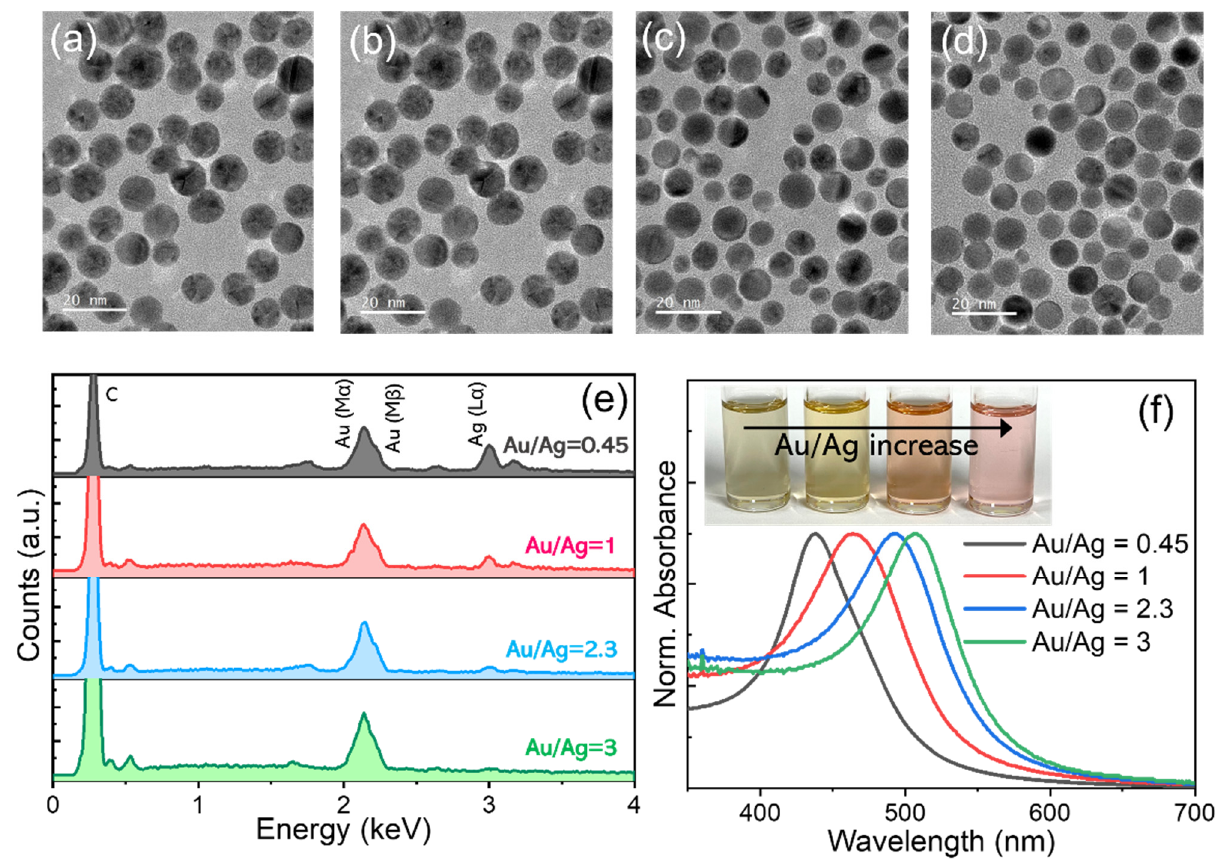
Figure 2. TEM images of AuAg alloy NPs synthesized with Au/Ag precursor ratios of ( a ) 0.45, ( b ) 1, ( c ) 2.3, and ( d ) 3 (scale bars are 20 nm for all). Comparison of ( e ) EDS spectra and ( f ) normalized absorption spectra (measured from dispersion in chlorobenzene) of a series of the composition-varied AuAg NPs.